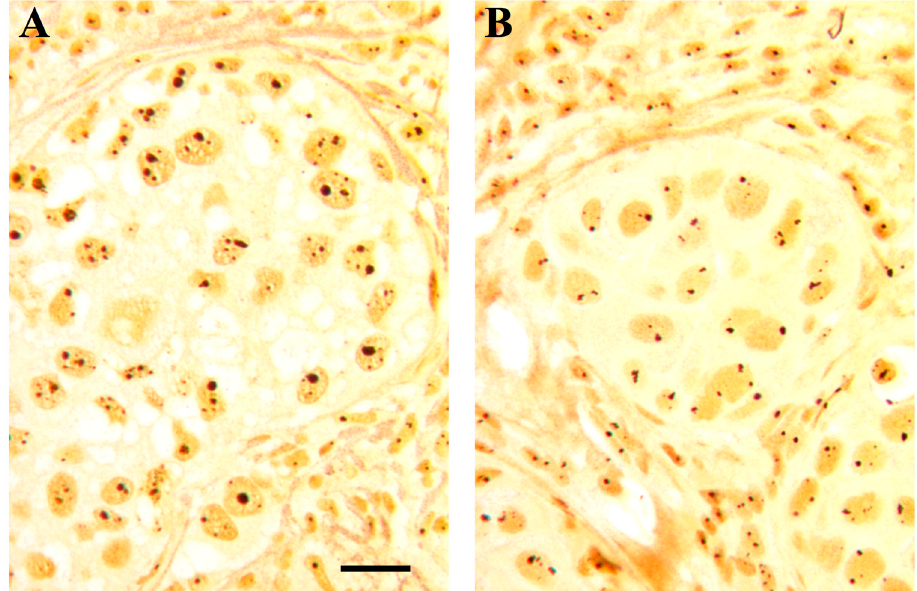
Figure 3. Histological sections from two cases of infiltrating ductal carcinomas after selective silver staining for NOR proteins; note the different quantitative distribution of the silver-stained structures in ( A ) (characterized by a high proliferation index, mutated p53 and RB loss) and ( B ) (characterized by a low proliferation index, wild type p53 and normal RB). Bar, 10 µm.